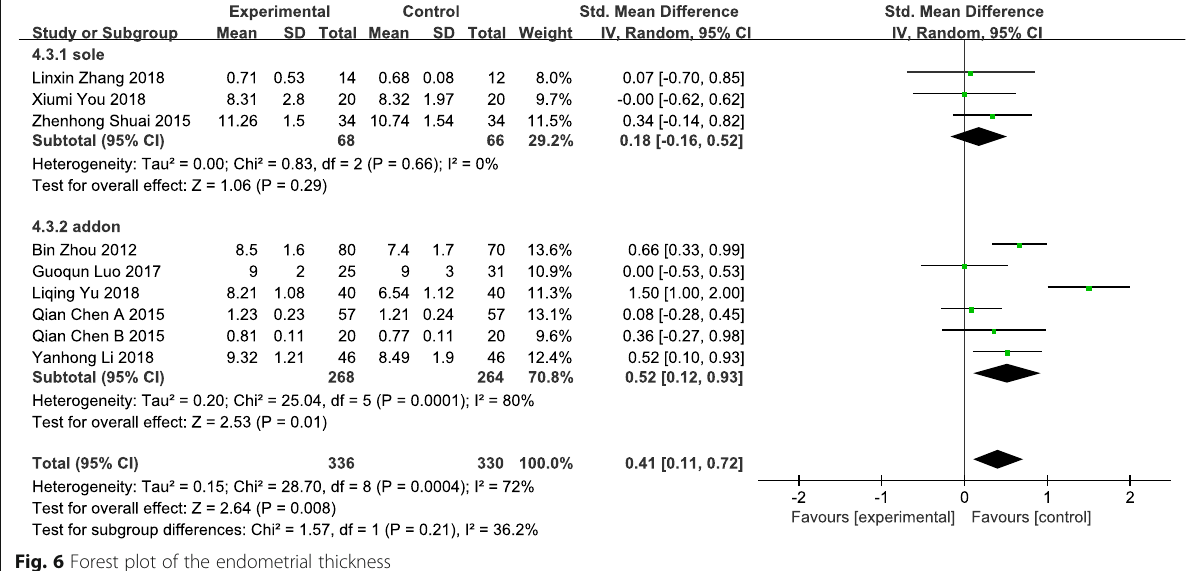
Fig. 6 Forest plot of the endometrial thickness